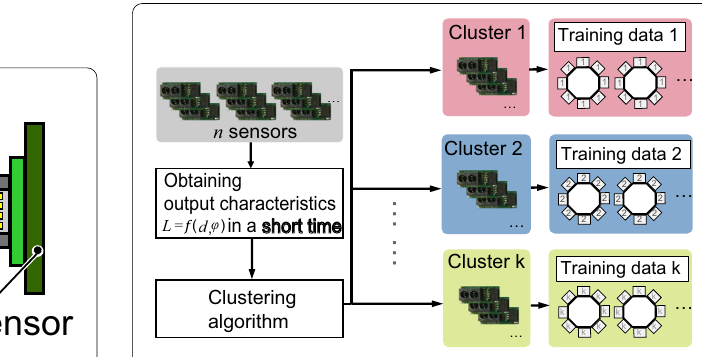
Fig. 3 Definition of distance d and tilt ϕ Fig. 4 Overview of sensor